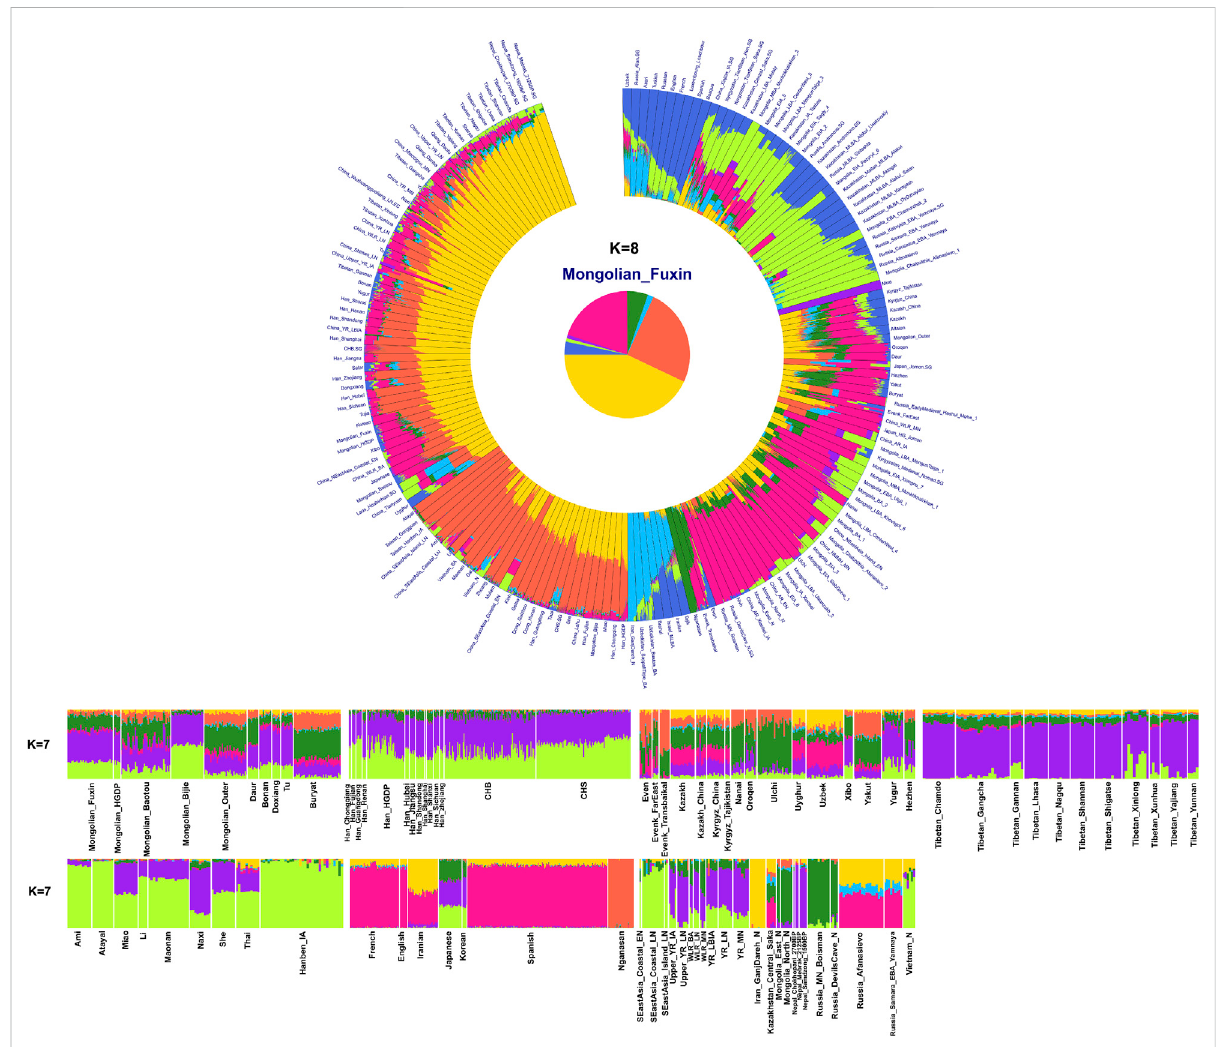
FIGURE 4 Results of model-based admixture clustering analysis showed the ancestral composition of studied Mongolians and reference populations at K = 7 and K =